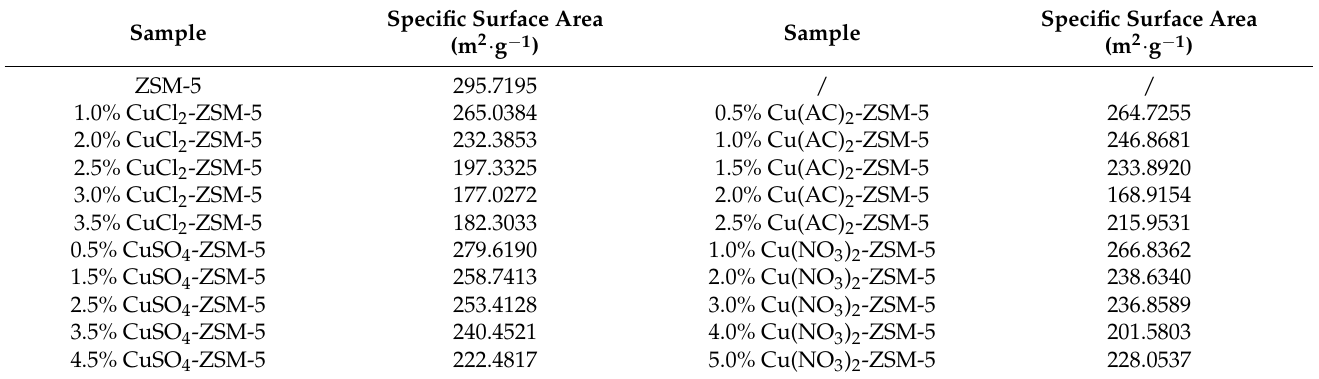
Table 3. Specific surface area of different Cu-ZSM-5 molecular